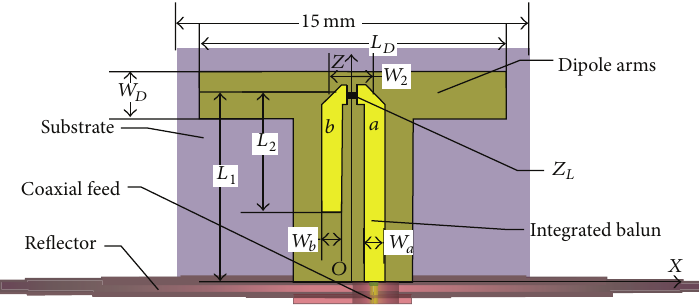
Figure 3: Geometry of the modified model.